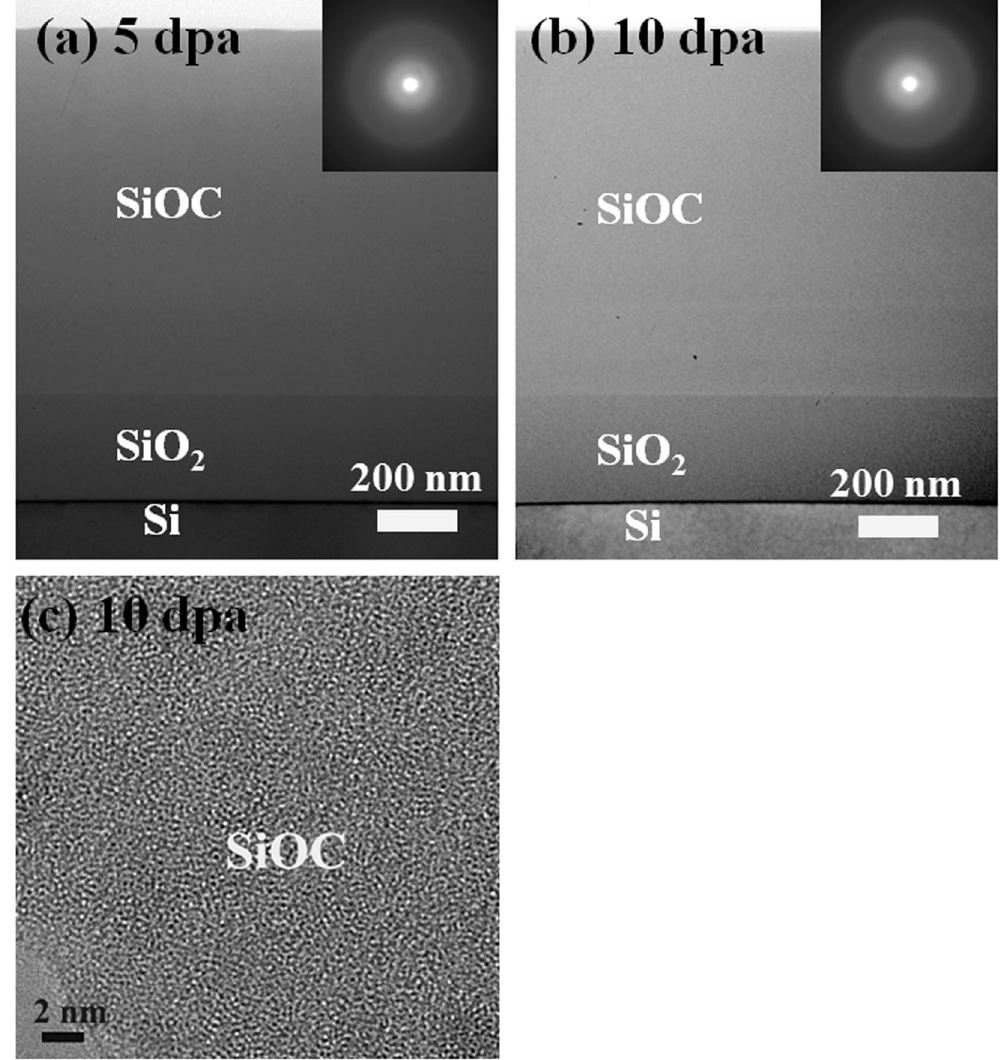
Figure 2. Cross-sectional TEM micrographs of SiOC film after ( a ) 5 (15) and ( b ) 10 (30) dpa irradiation at 200 nm (800 nm) regions. No void formation, element segregation or crystallization are present in pure irradiation region. ( c ) High resolution TEM image of SiOC film in the 20 nm region after 10 dpa irradiation exhibiting a maze-like pattern with no discernable